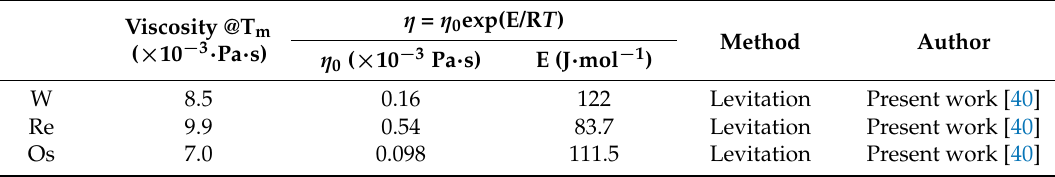
Figure 11. Viscosity of W, Re, and Os versus temperature. Table 4. Measured viscosity data of W, Re, and